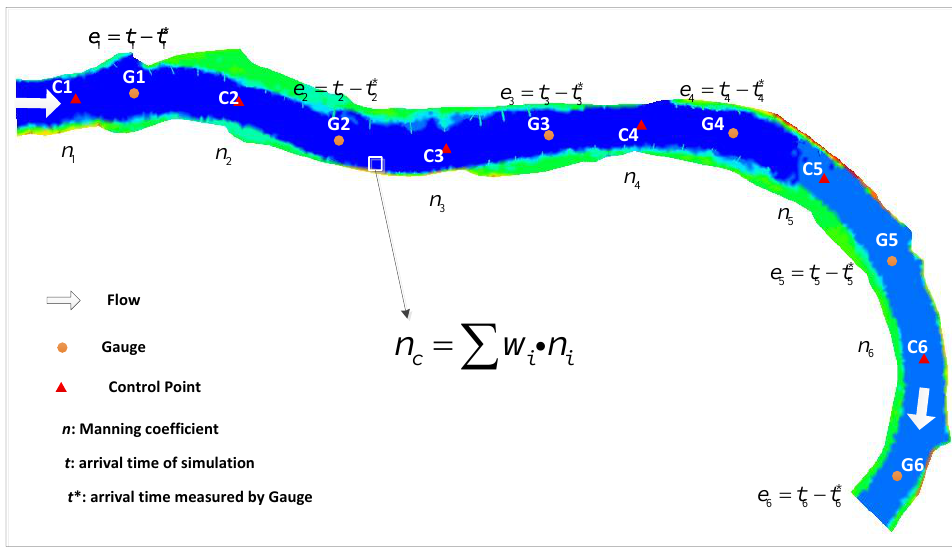
Figure 4. Spatialized design of the Manning